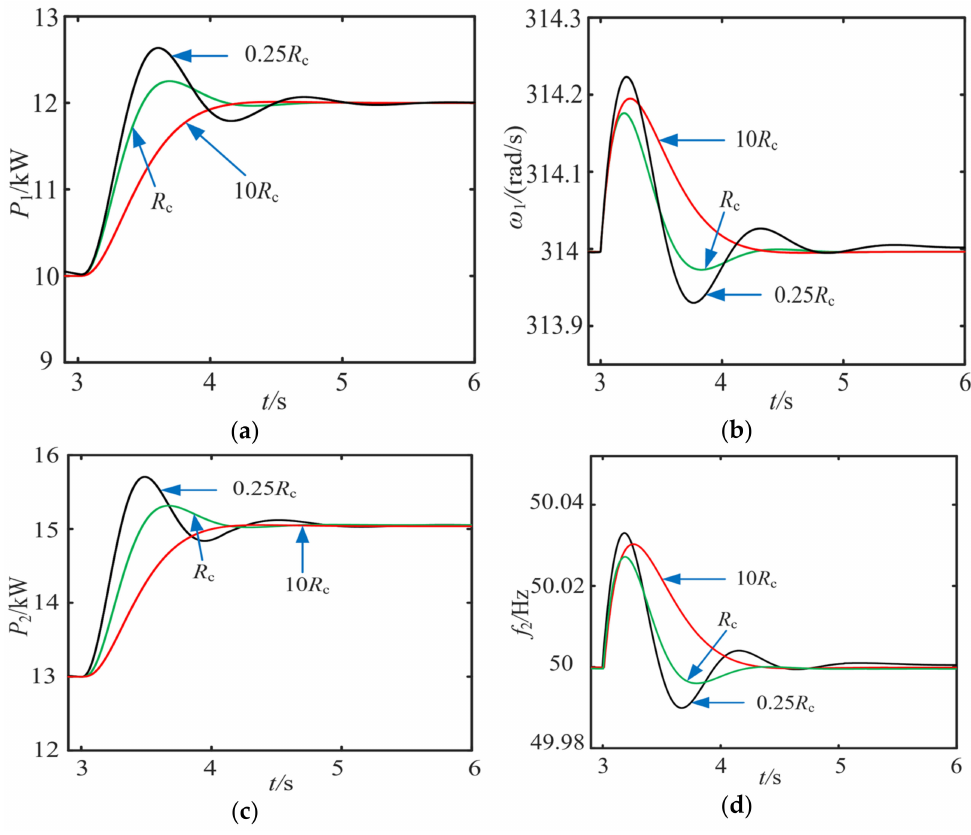
Figure 16. Simulation waveforms with different line resistances: ( a ) active power of VSG1; ( b ) virtual angular frequency of VSG1; ( c ) active power of VSG2; ( d ) frequency of